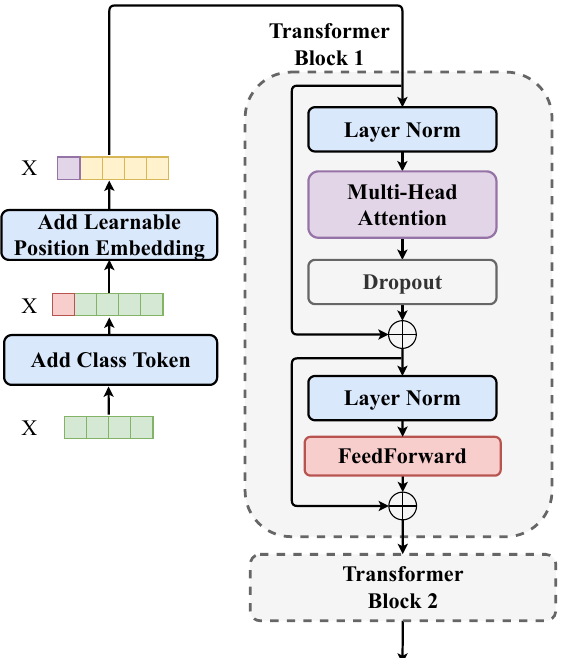
Figure 5. Schematic diagram of the Transformer part of the AMSCN. Before the features are fed into the first transformer block, preprocessing is required, i.e., adding the classification token and position embedding.